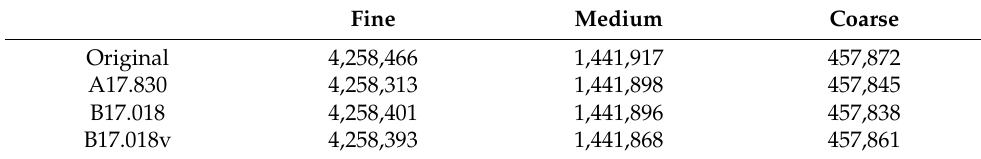
Table 2. Grid numbers for different grid